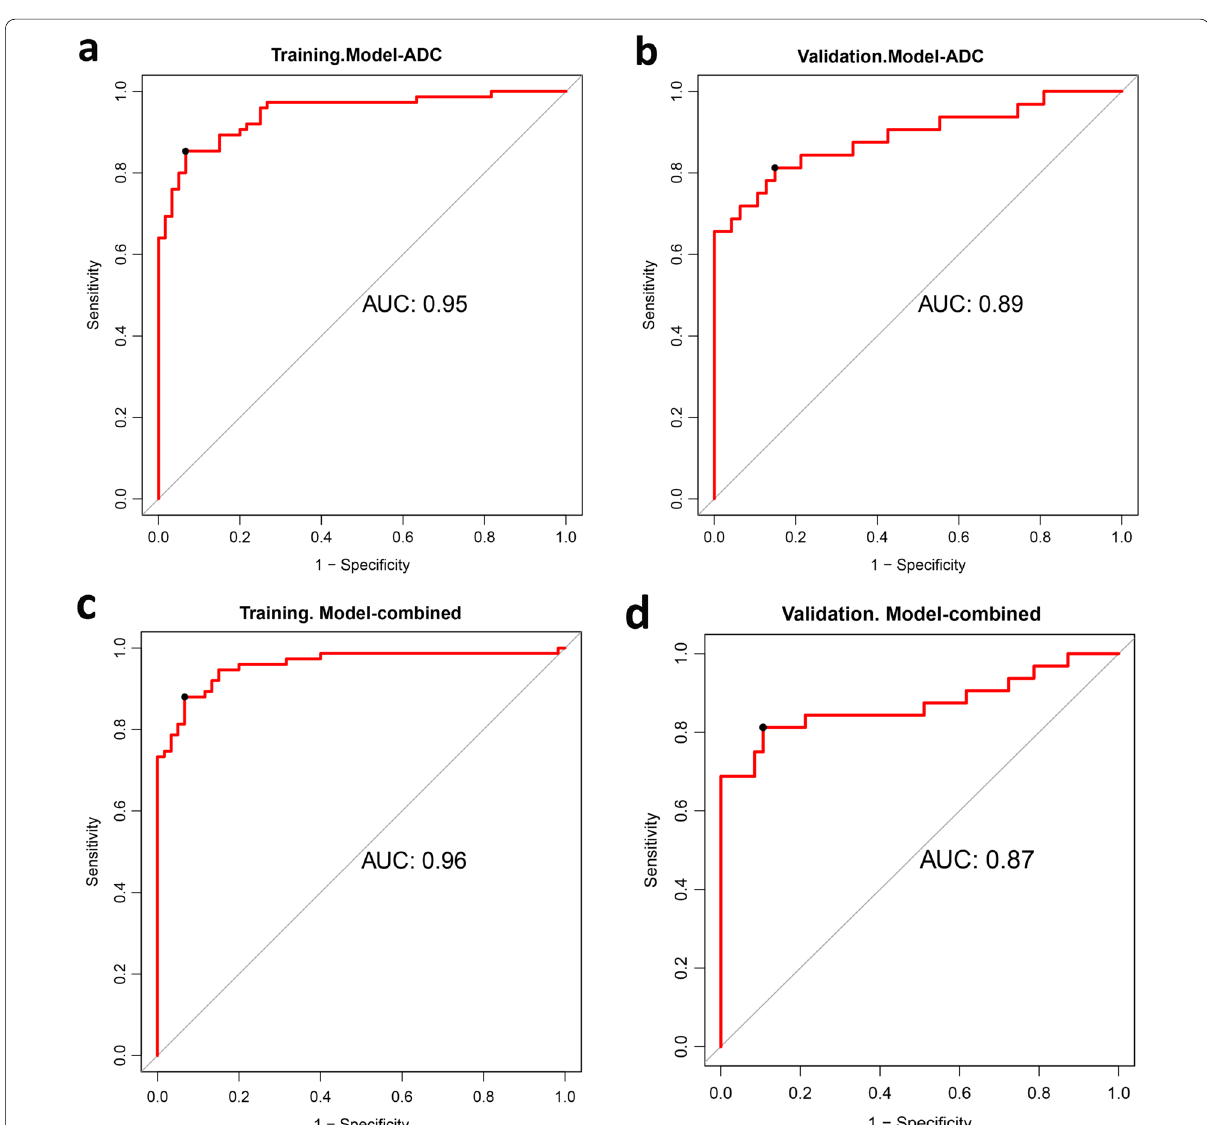
Fig. 3 Performances of two models in training cohort and validation cohort, respectively. a , b Rad-score, including four histogram parameters. c , d Combined model, integrated T stage and four histogram